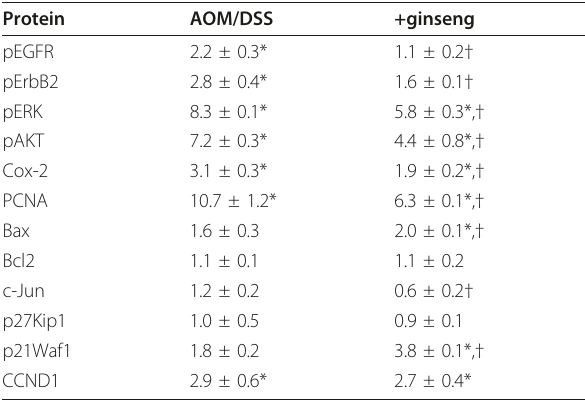
Table 2 EGFR signals and apoptosis mediators